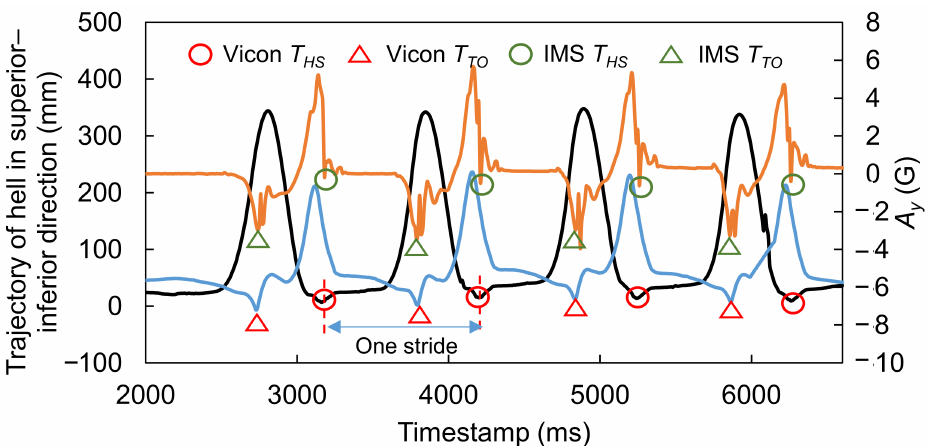
Figure 5. Example showing how to divide data into strides. Black and blue curves represent the trajectories of the heel and toe in the Z direction, and the orange curve represents IMS signal A y